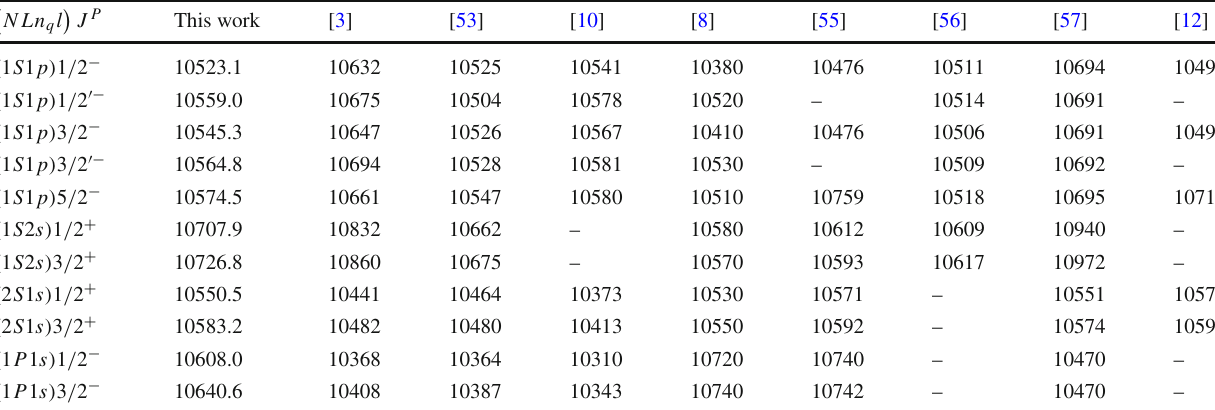
Table 11 Mass spectra of (cid:2) bb baryons (in MeV). Our results are obtained by the respective sum of the mean mass of the (cid:2) bb in Table 3, the binding energy shift(vanishes in 1S1s wave) in Table 9 and its splittings in Sect. 3 with the couplings given in Sect. 4